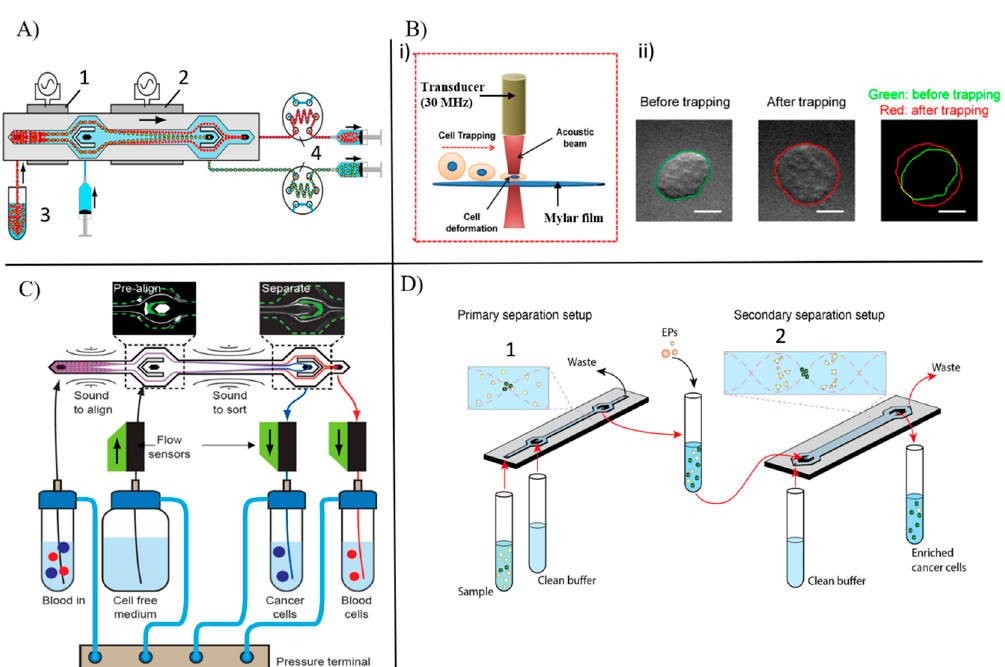
Figure 4. Acoustophoresis-based cell trapping ( A ) Microfluidic chip based on acoustophoresis for alignment and capturing of the cells and the direction of flow for acoustophoretic separation of cells (1 and 2—piezoceramic transducers, 3—cell sample drawn via suction from the test tube, 4—two- sample loops for sample outlet) (adapted from [87]). ( B ) (i) Set-up for capturing and monitoring deformation of a cell (ii) images showing the size of the cell before and after trapping (adapted from [89]). ( C ) Schematic showing a complete set-up with microfluidic channels and external components for acoustophoresis-based separation of cells. Green boxes in this set-up represent flow sensors that regulate the pressure of the container (reproduced with permission from [90]). ( D ) Picture showing primary and secondary separation chip for two-step acoustophoresis separation approach in which elastomeric particles (Eps) are introduced in the sample obtained after primary separation to deplete WBCs. (Blue rectangular box 1 shows acoustic standing wave of half wavelength forcing the cells towards the center and 2 represents multimode separation) (adapted from [91]).